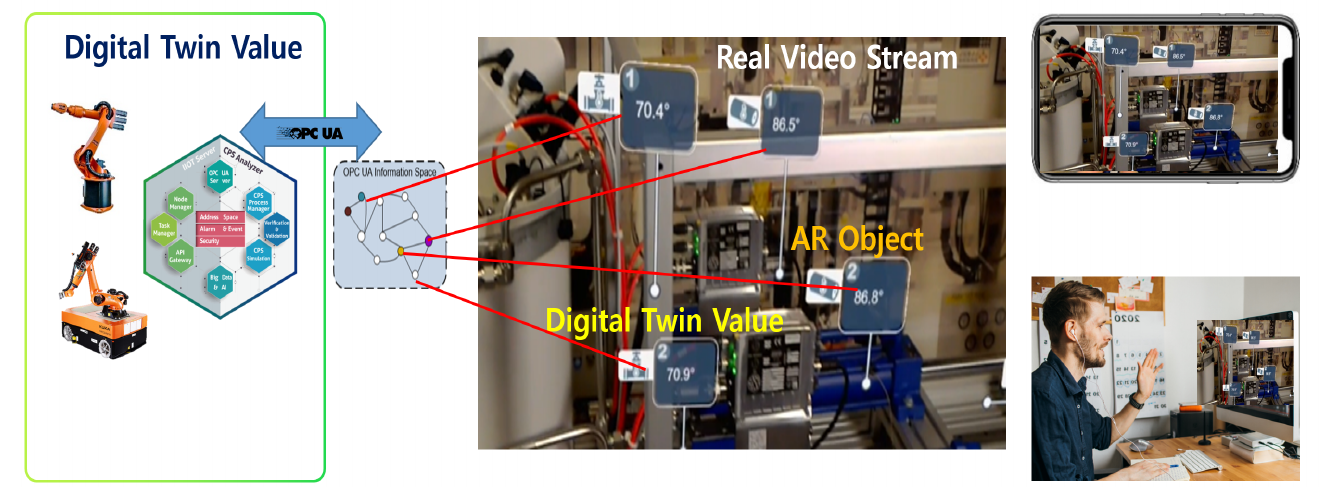
Figure 3. OPC UA information space of VR engineering.